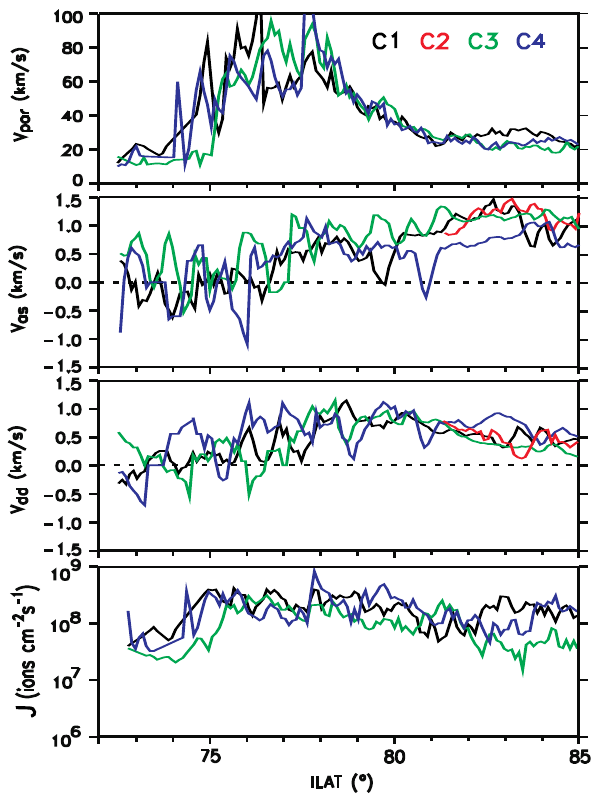
Fig. 4. From top to bottom, plots of the upward mean velocity, the antisunward and the dawn-dusk components of the ionospheric con- vection drift, and the integral upward flux as a function of invariant latitude on 23 September 2001. All quantities are averaged in lati- tudinal bins of 0.1 ◦ . The colours refer to C1 (black), C2 (red), C3 (green) and C4 (blue).